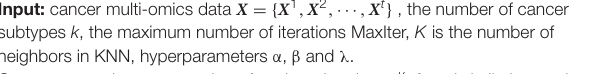
Algorithm 1 : MRF-MSC